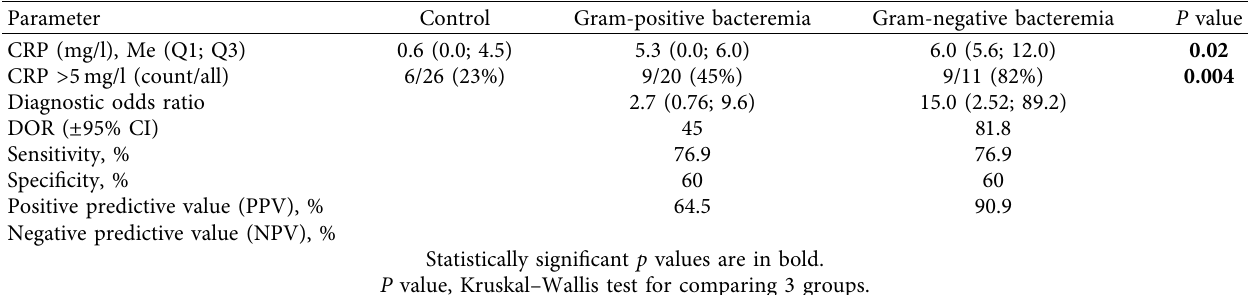
Table 2: CRP data in the study groups.